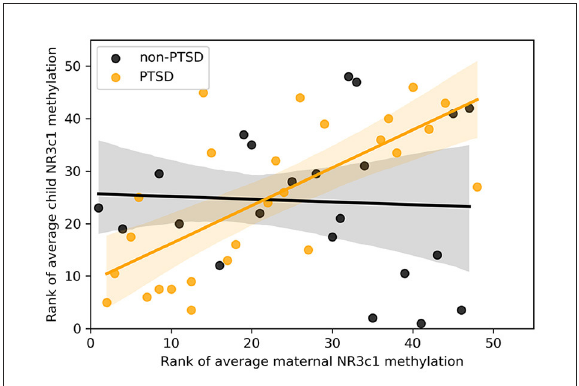
FIGURE1 Scatter plot of rank of average methylation of the NR3C1 gene for children and mothers across all 13 CpGs, split by whether mothers had significant symptoms of interpersonal violence related post-traumatic stress disorder.